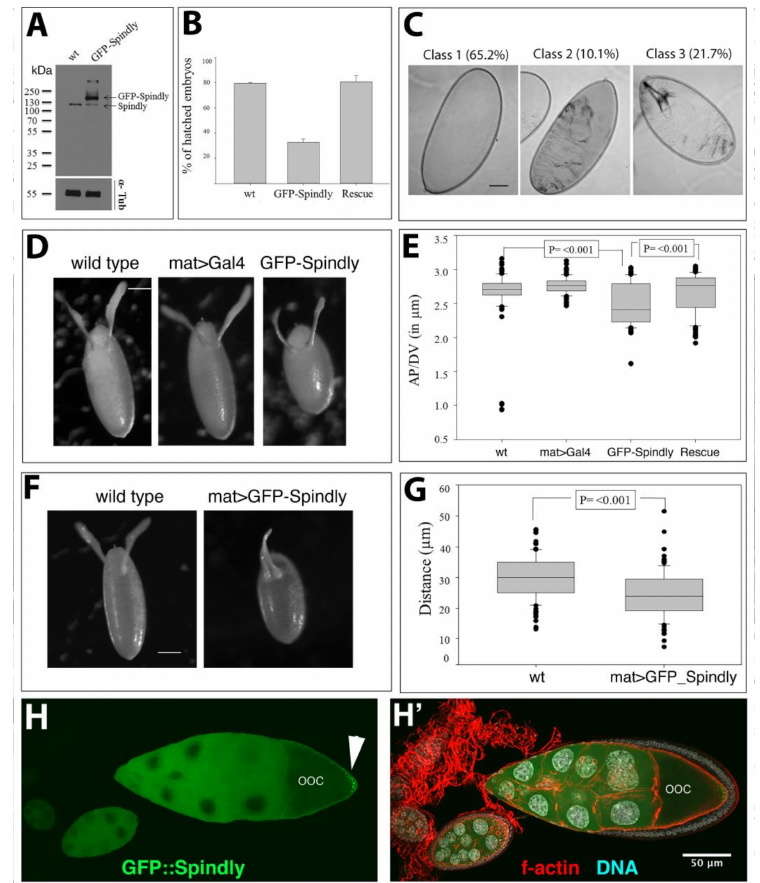
Figure 6. Overexpression of Spindly affects oogenesis and embryogenesis. ( A ) Immunoblot analysis of Spindly in lysates from wild-type ( wt ) and nos>>Gal4 :: UAS>>GFP::Spindly (GFP::Spindly) embryos. Endogenous Spindly and GFP::Spindly bands are indicated ( α -tubulin—loading control; molecular weight markers in kDa); ( B ) Survival rate of embryos upon Spindly overexpression scored by larval hatching ( n = 100). Viability was restored by knock-down of endogenous Spindly with UAS>>Spindly[RNAi] (Rescue); ( C ) Larval cuticle defects in mat67>>Gal4 : UAS>>GFP::Spindly. The majority of embryos died before cuticle deposition (65.2%, class 1). The remaining 31.8% of embryos exhibited dorsal holes (class 2) or segmentation defects (class 3) ( n = 138); ( D ) Eggs laid by mat67>>Gal4 :: UAS>>GFP::Spindly females exhibited abnormal rounded shape (48%, n = 100). Scale bar represents 50 µ m; ( E ) Quantification of egg size by calculating the ratio between the length (A/P axis) and the width (D/V axis) for a total of 100 eggs (Mann-Whitney Test ( p ≤ 0.001). This phenotype is suppressed by UAS>>Spindly[RNAi] knock-down of endogenous Spindly (Rescue); ( F ) Moderate ventralisation defect in chorions of mat67>>Gal4 :: UAS>>GFP::Spindly eggs. The dorsal appendages were shorter and apposed closer to each other along the dorsal midline compared to controls. Scale bar represents 50 µ m; ( G ) Quantification of the distance between dorsal appendages shown in ( F ) (Mann-Whitney Test p ≤ 0.001; n = 100); ( H ) Part of an ovariole from an ovary of a mat67>>Gal4 :: UAS>>GFP::Spindly female fixed and stained with antibodies against GFP (green), f-actin (red) and DAPI (blue). Note the accumulation of GFP::Spindly (arrowhead) at the posterior pole of the oocyte (ooc) in the egg chamber (stage 10). Scale bar: 50 µ